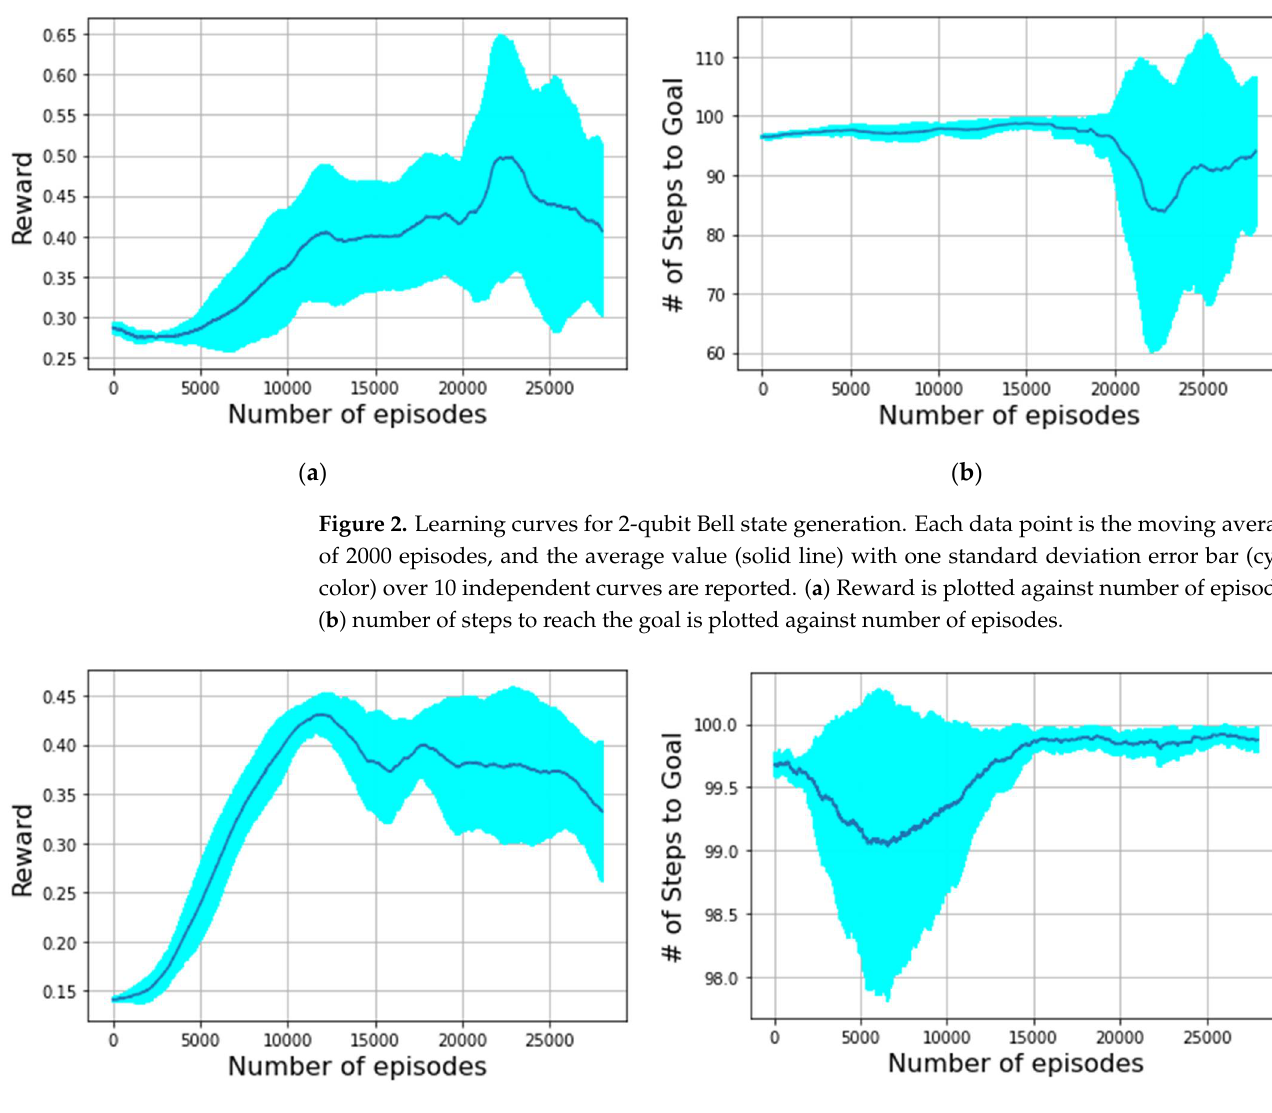
Figure 3. Learning curves for 3-qubit GHZ state generation. Each data point is the moving average of 2000 episodes, and the average value (solid line) with one standard deviation error bar (cyan color) over 10 independent curves is reported. ( a ) Reward is plotted against number of episodes; ( b ) number of steps to reach the goal is plotted against number of episodes.